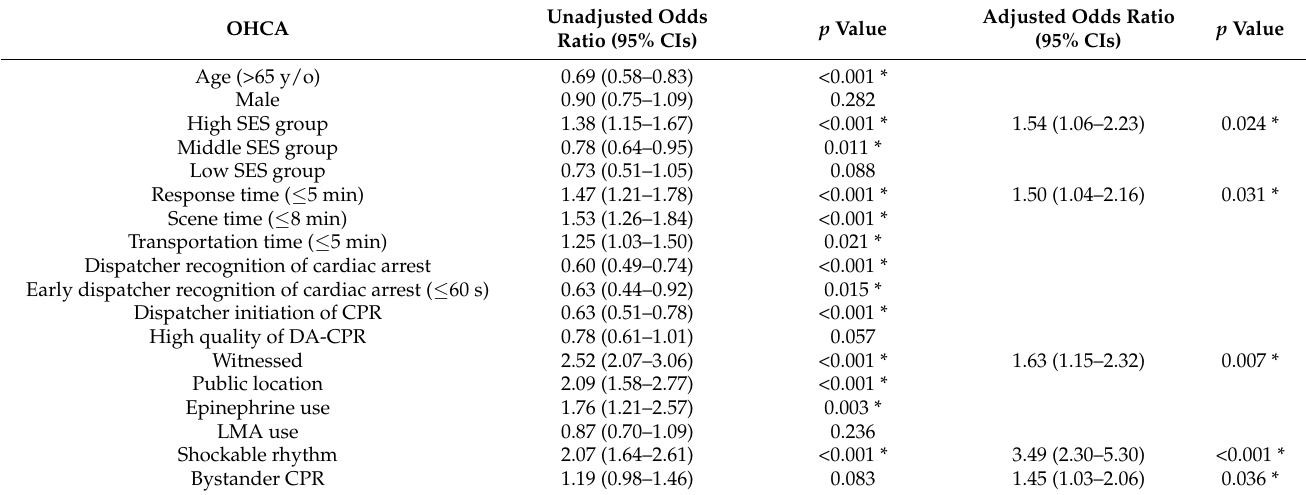
Table 4. Analysis of sustained return of spontaneous